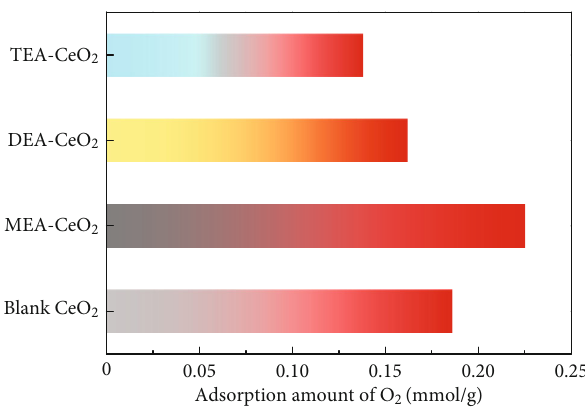
Figure 1: XRD patterns of (a) the precursors synthesized solvothermally at 120 ° C for 24h and (b) the fi nal products synthesized followed by calcination in air at 500 ° C for 2h.